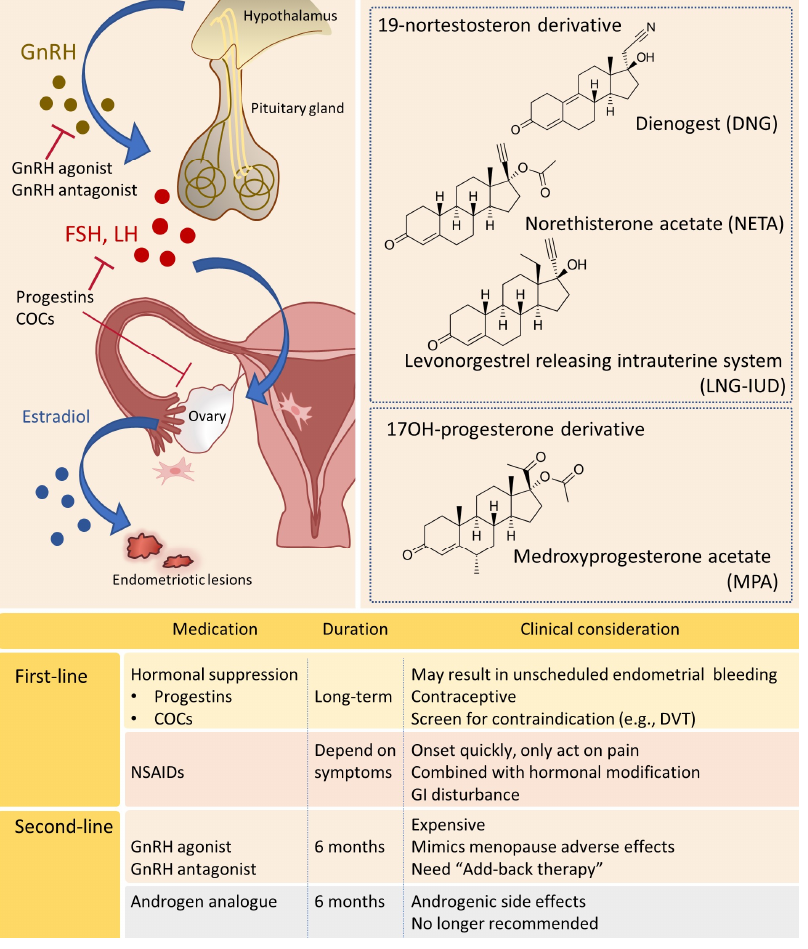
Figure 4. Medical treatments for endometriosis